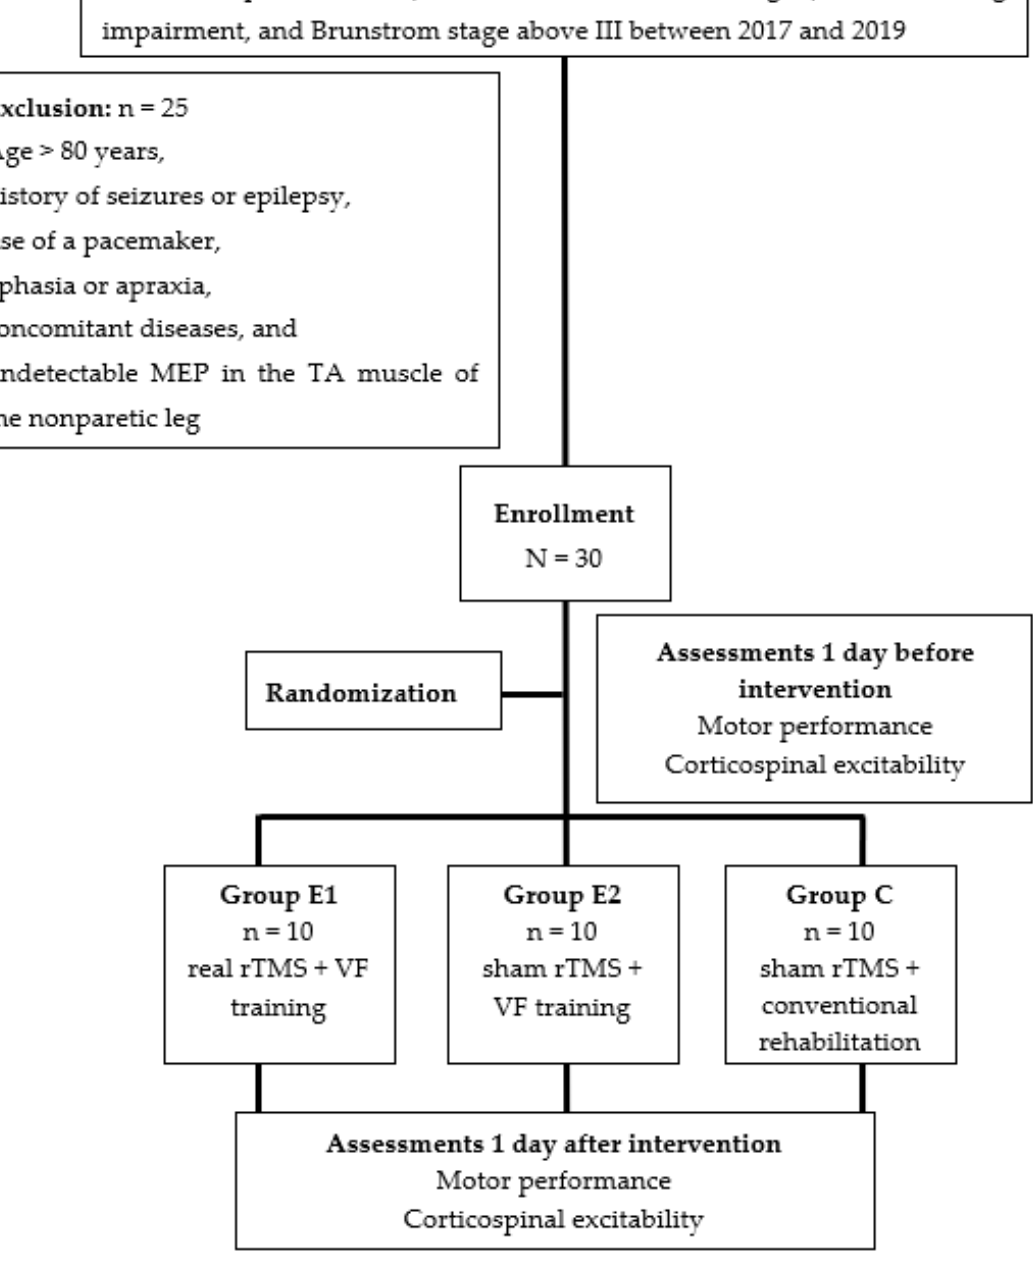
Figure 1. Enrollment flowchart.